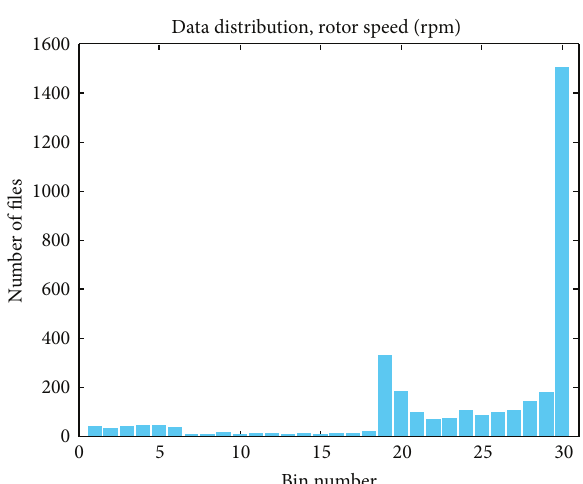
Figure 15: Distribution of the wind turbine data gathered using 30 bins.